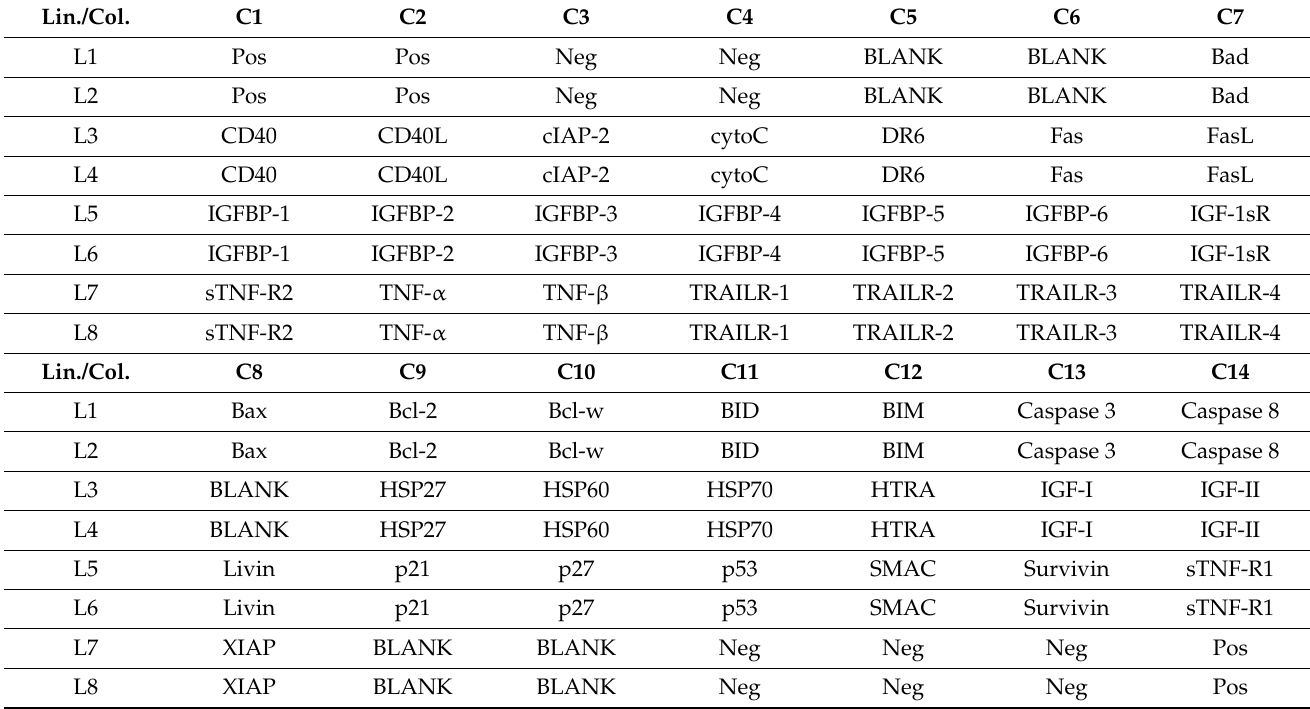
Table 2. Apoptosis protein array